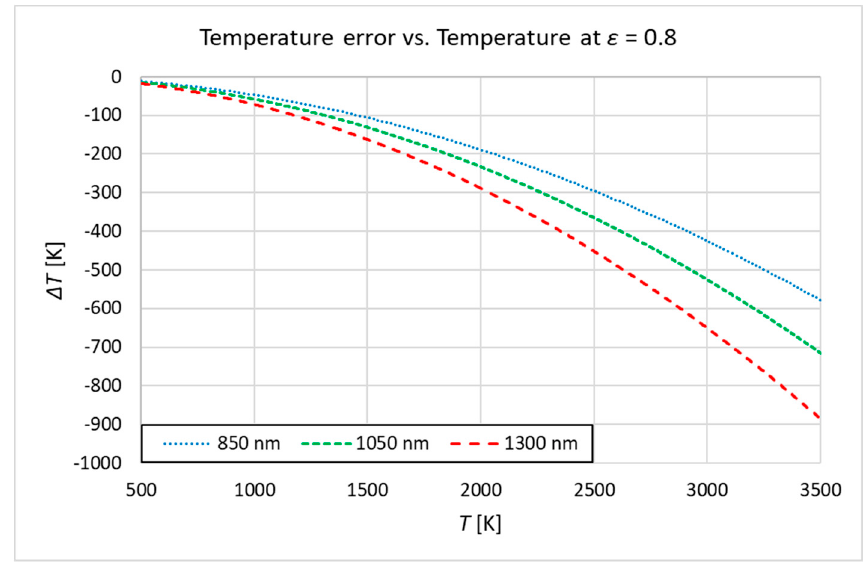
Figure 14. Plot of temperature error versus temperature for ε = 0.8 and for the three chosen wavelengths.